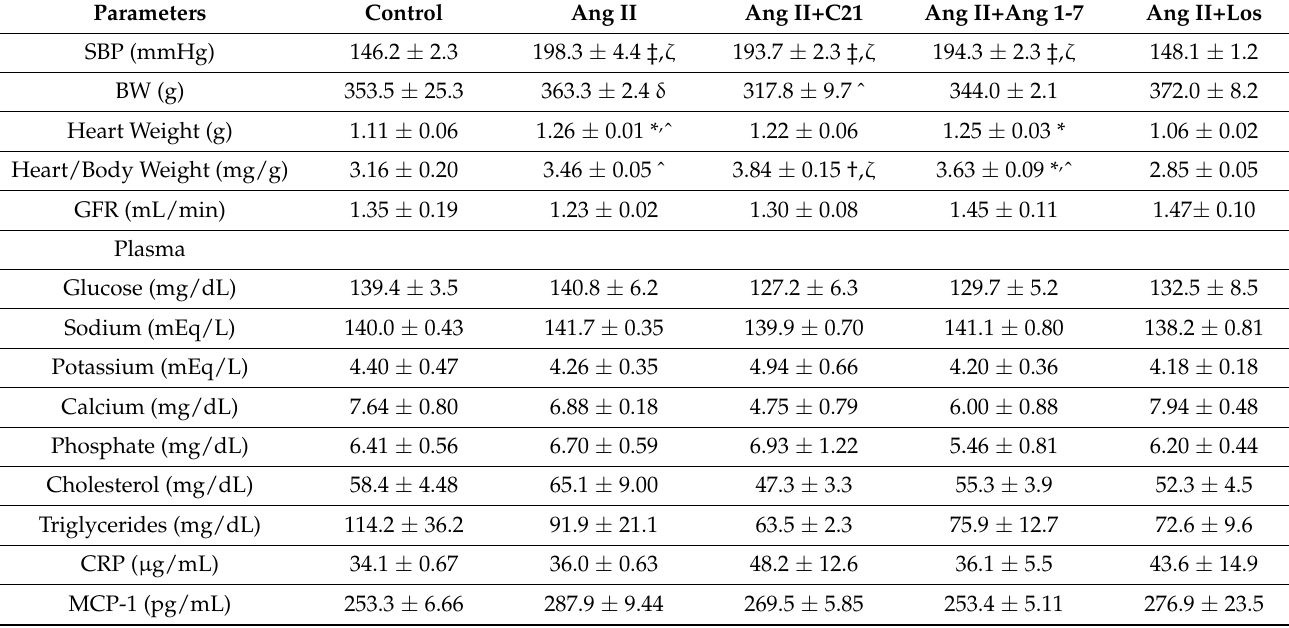
Table 1. Systolic blood pressure (SBP, mmHg), body weight (BW, g.), heart weight (g.), heart/body weight ratio (mg/g.), glomerular filtration rate (GFR, mL/min); non fasting plasma glucose (mg/dL), sodium (mEq/L), potassium (mEq/L), calcium (mg/dL), phosphate (mg/dL), total cholesterol (mg/dL), triglycerides (mg/dL), C reactive protein (CRP, µ g/mL) and monocyte chemoattractant protein (MCP-1, pg/mL) in Control ( n = 5), Ang II ( n = 5), Ang+C21 ( n = 5), Ang II+Ang 1-7 ( n = 5), Ang II+Los ( n = 5)-treated rats at the end of the short term experimental period (1 week).